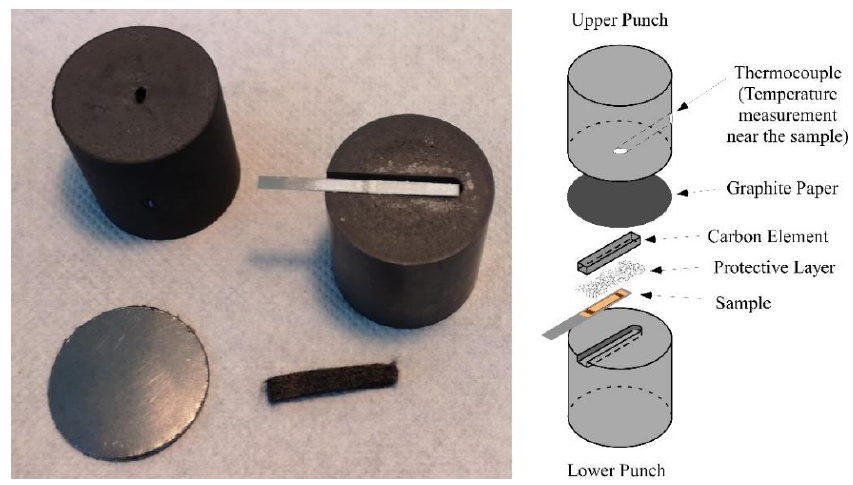
Figure 10. Final optimized configuration for the modified SPS graphite die.